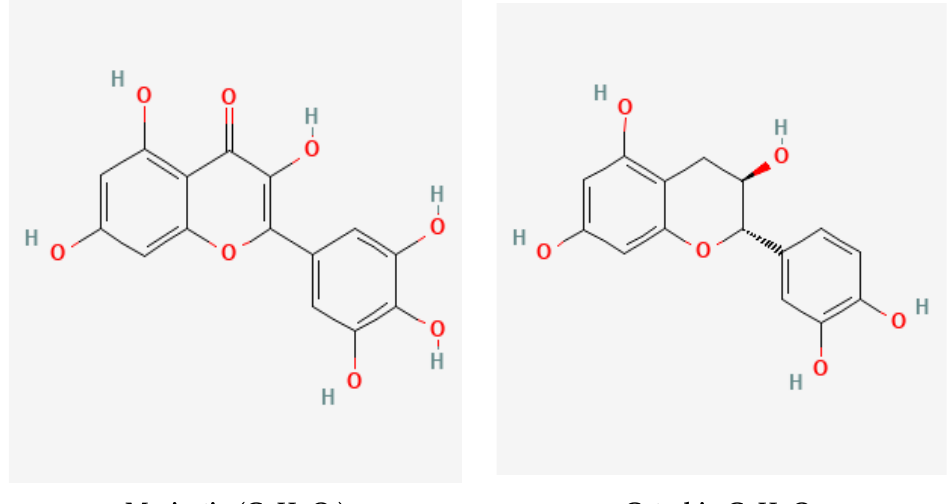
Figure 3. Chemical structures of the HPLC-detected flavonoids in GB leaves (https://pubchem.ncbi.nlm.nih.gov), accessed on 15 April 2022. Table 3. HPLC chromatogram of phenolics from GB leaves.